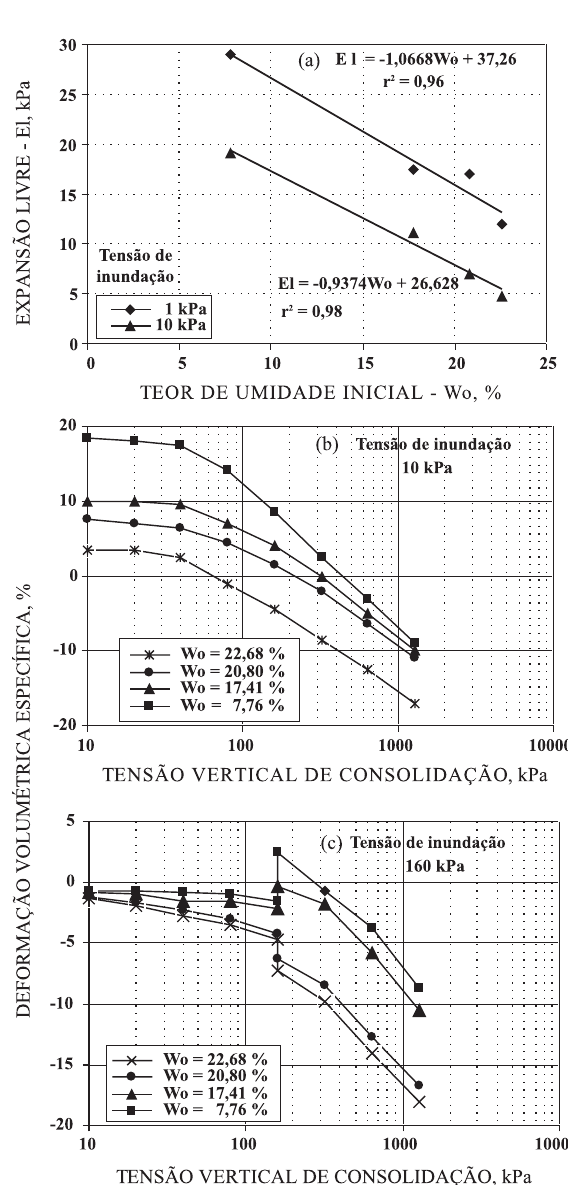
Figura 9. Influência da umidade inicial: (a) na expansão “livre”; (b) na compressibilidade; e (c) na expansão ou colapso sob tensão. EI: expansão livre; Wo: umidade gravimétrica inicial; r 2 : coeficiente de correlação.